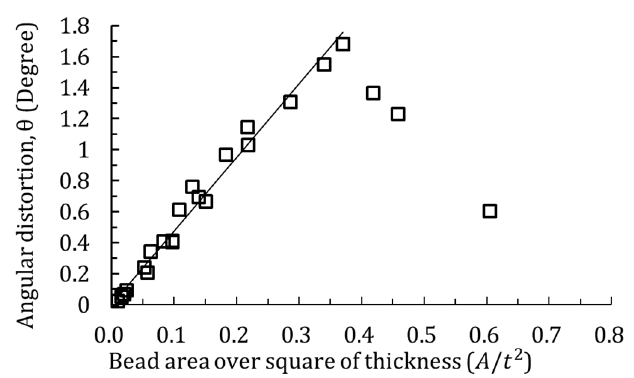
Figure 6. Relationship between angular distortion and ratio of bead area to square of thickness.